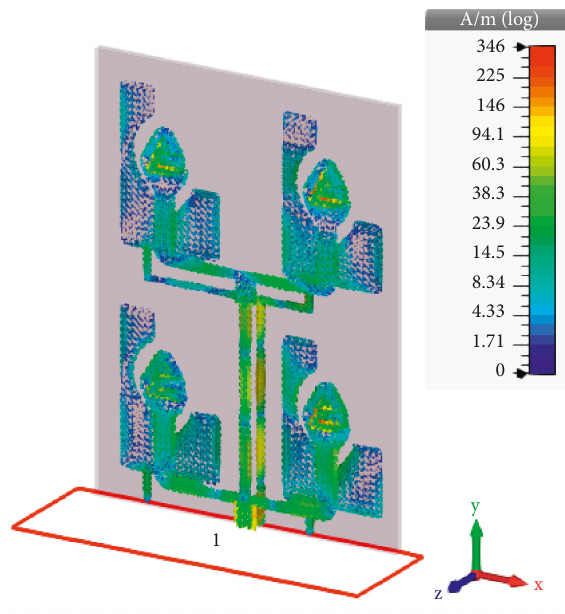
Figure 27: Surface current at 60GHz of the 1 × 2